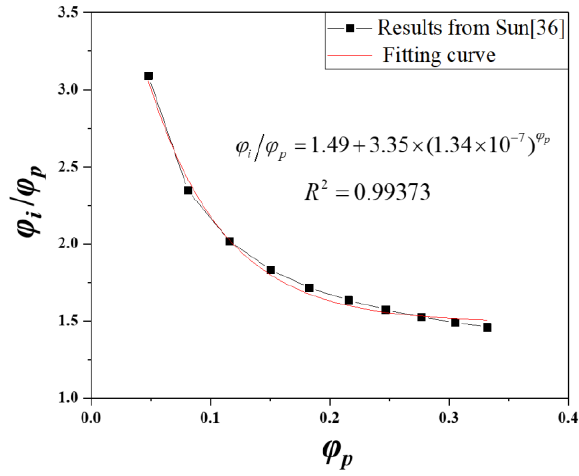
Figure 1. Fitted relationship between φ i and φ p .